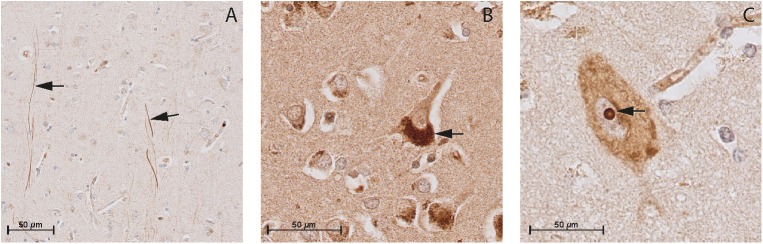
Immunohistochemistry of CNP, NPR-B, and NPR-A in the gray matter of non-demented controls. (A) Immunohistochemistry of CNP in the gray matter. Arrows point to CNP-positive fibers in the gray matter; (B) Immunohistochemistry of NPR-A in the gray matter. Arrow point to the granular bodies resembling Nissl bodies in the cytoplasm of neuron, and (C) Immunohistochemistry of NPR-B in the gray matter. Arrow point to the nucleolus of the neuron.